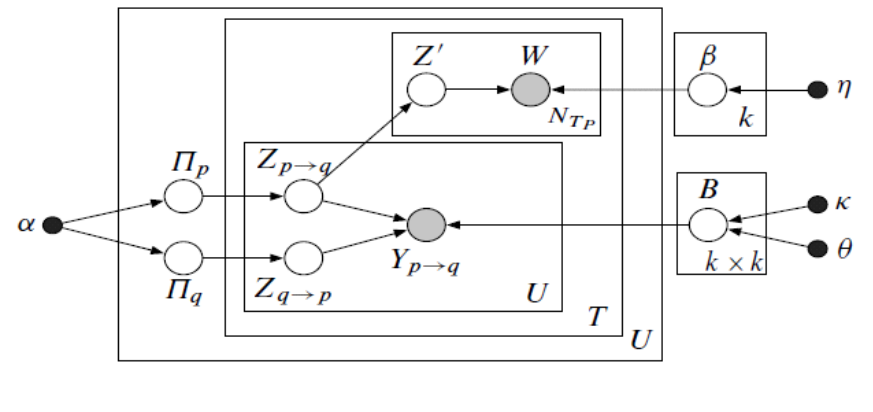
Figure 1. Graphical representation of the integrated LDA-MMSB